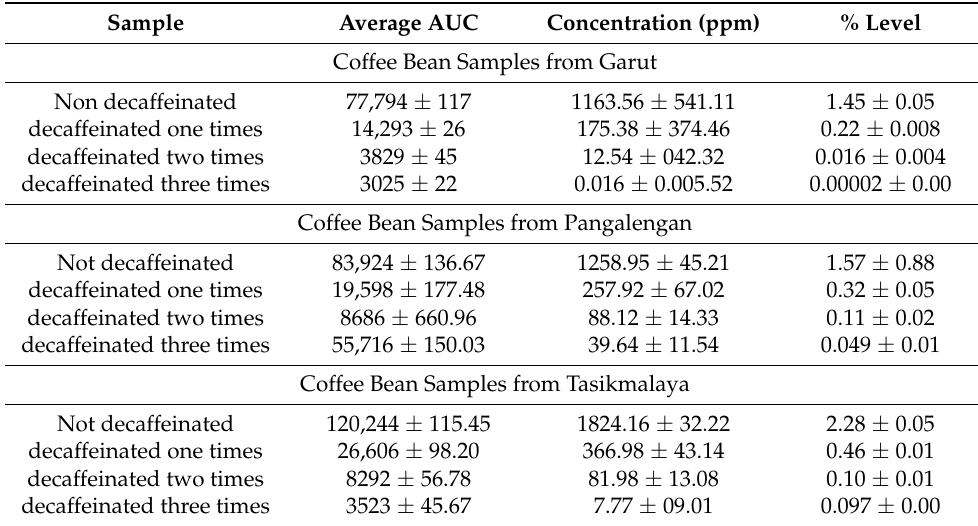
Table 2. The caffeine content in coffee bean samples from three districts.